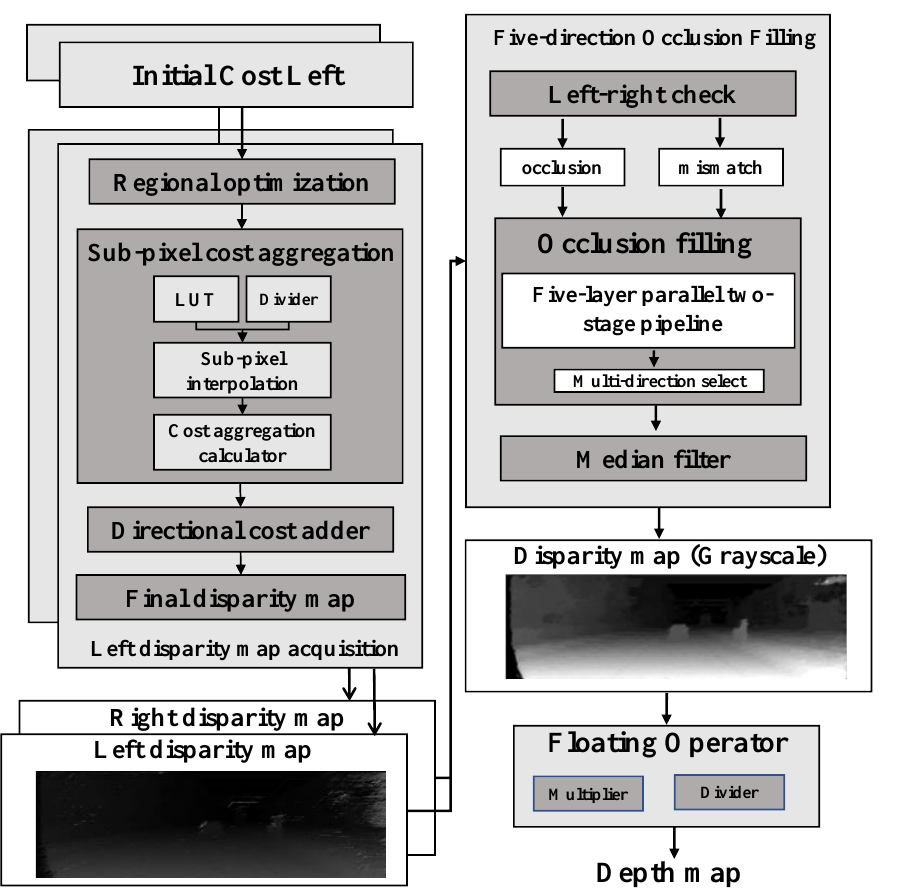
Figure 7. The hardware implementation for sub-pixel cost aggregation and five-direction occlusion filling.